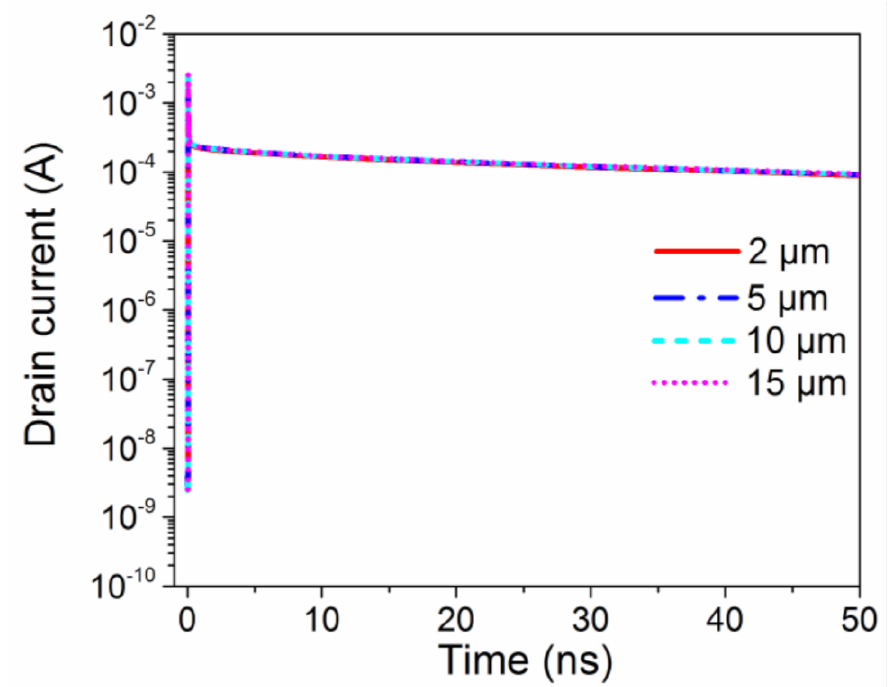
Figure 6. The transient drain currents after heavy-ion striking with different track